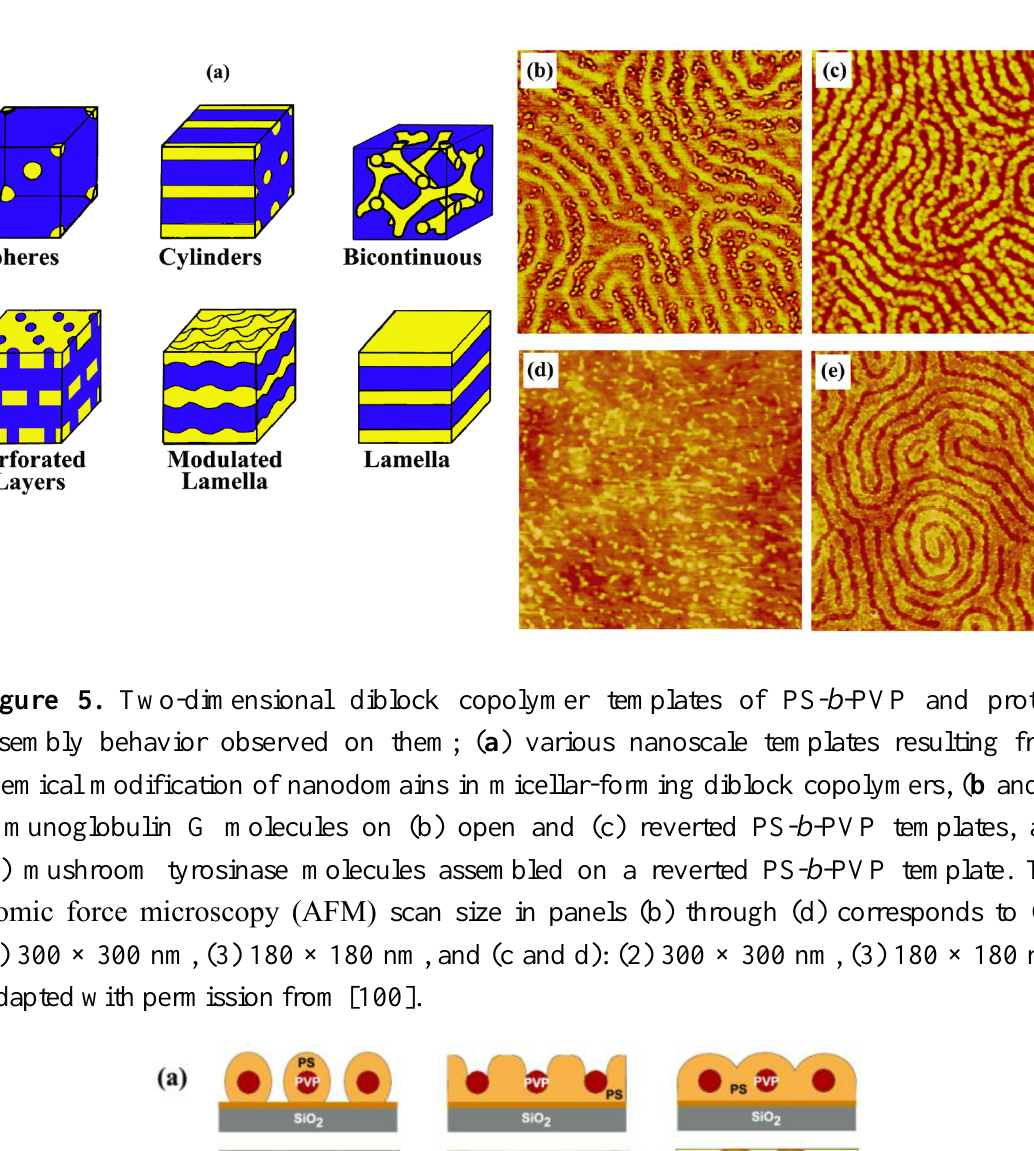
Figure 4. One-dimensional diblock copolymer templates of PS- b -PMMA and protein assembly behavior on them; ( a ) various nanoscale templates resulting from phase-separated nanodomains of diblock copolymers, ( b and c ) immunoglobulin G molecules assembled on PS- b -PMMA, and ( d and e ) protein G molecules on the same template. Panels (b) through (e) are 1 × 1  m atomic force microscopy (AFM) images. Adapted with permission from [97].